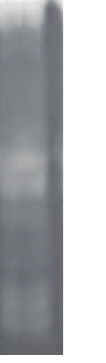
Figure 4: Fibrinogen zymogram of DLBS1033. LLP fractions which contribute to fibrinogenolytic activity were identified as clear